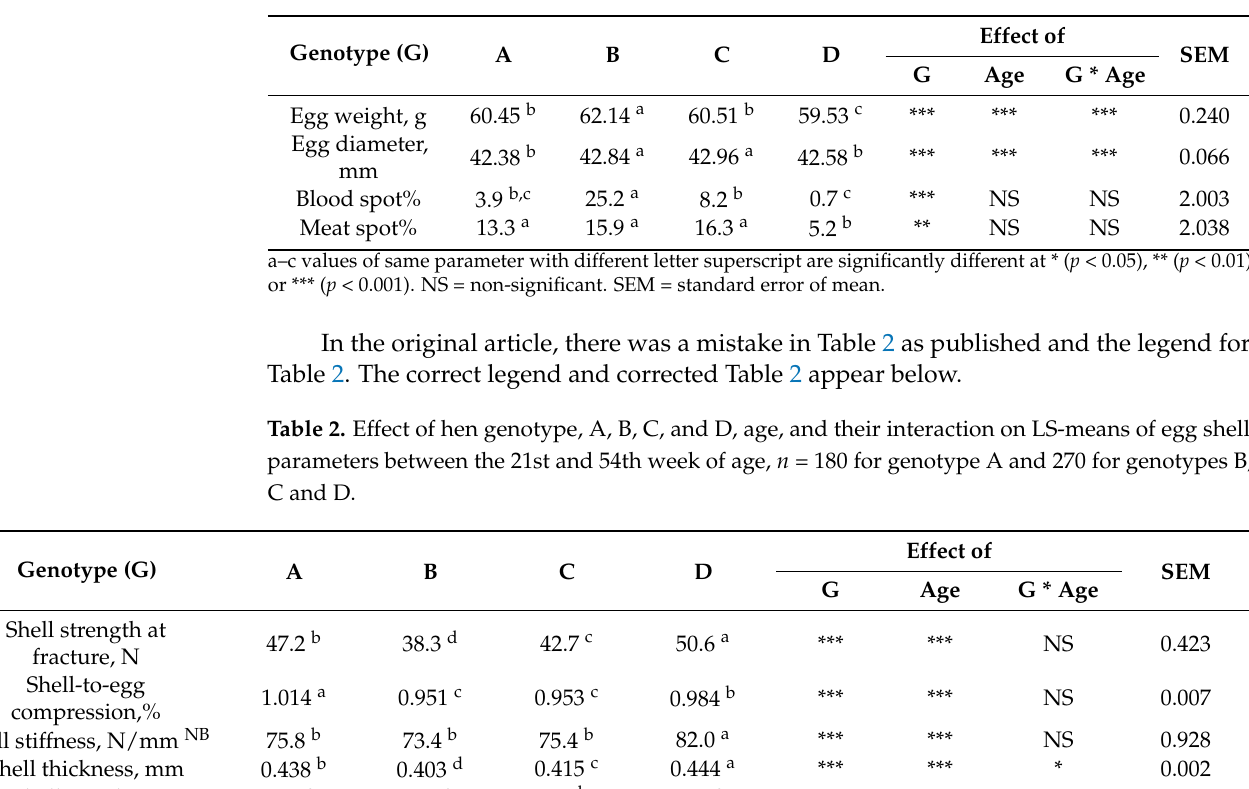
Table 1. Effect of hen genotype A, B, C, and D, age, and their interaction on LS-means of egg characteristics between the 21st and 54th week of age, n = 180 for genotype A and 270 for genotypes B, C and D. For blood spot and meat spot frequency, data are calculated as mean/unit/age, n = 12 for genotype A and 18 for genotypes B, C and D.